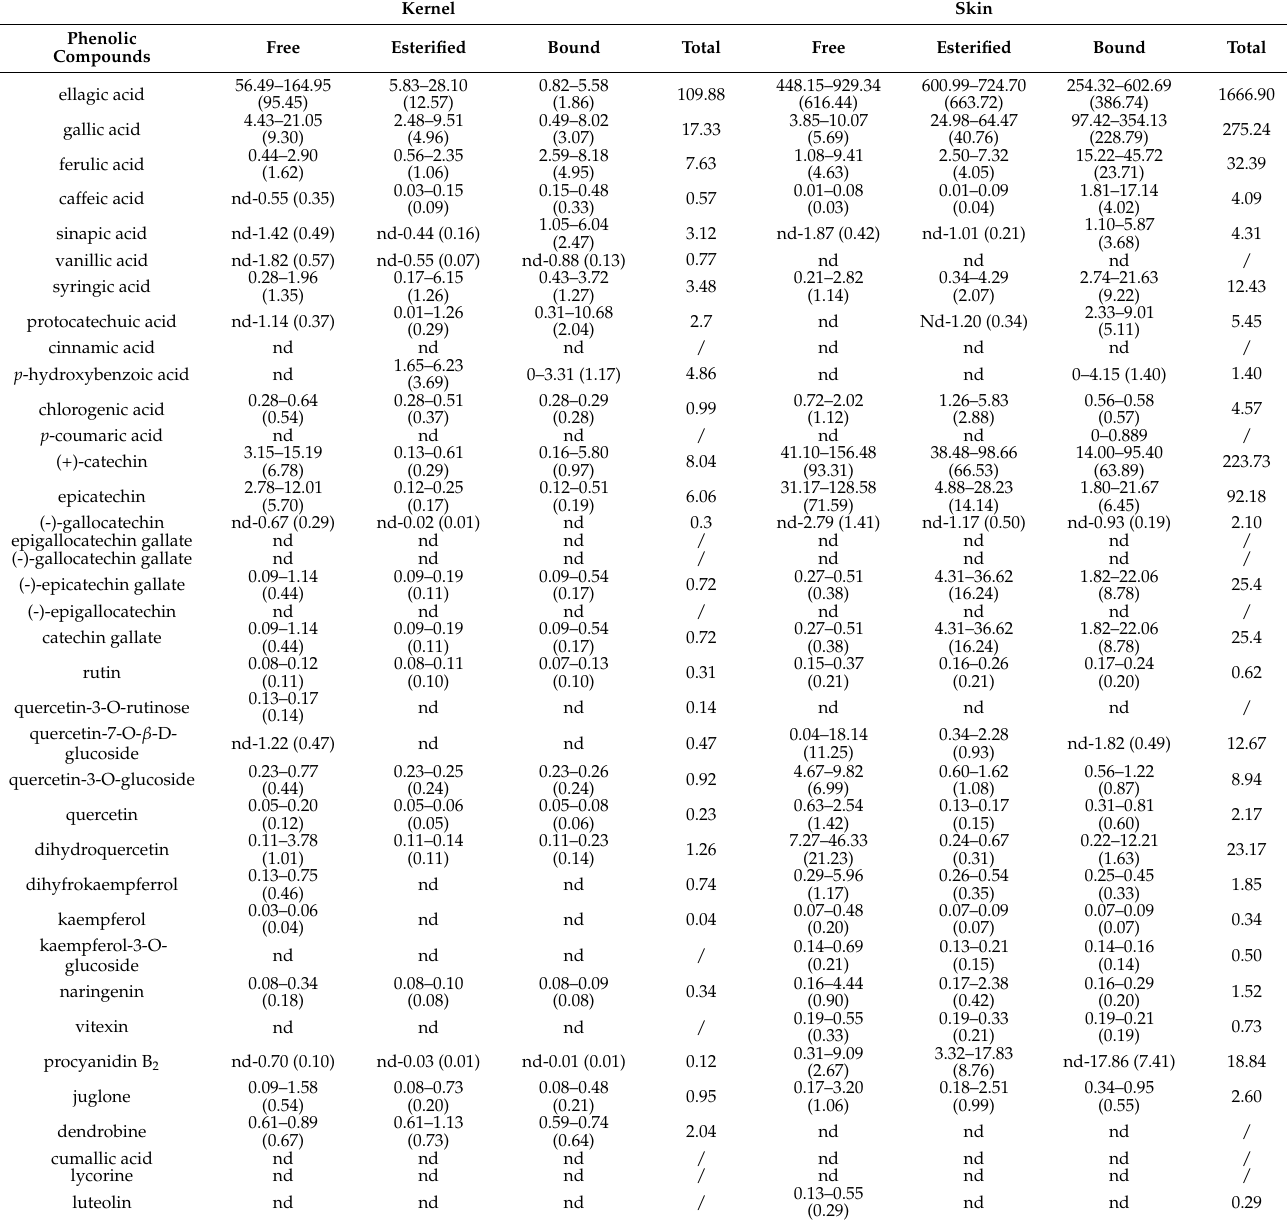
Table 2. The range of free, esterified, and bound phenolic contents ( µ g/g dry weight) in